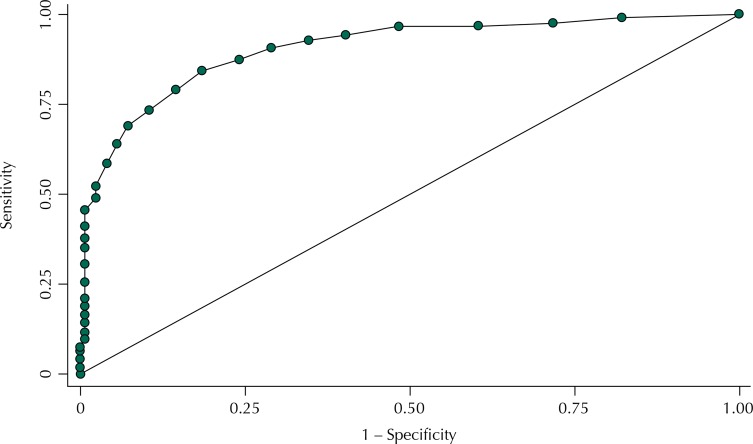
ROC curve evaluating sensitivity and specificity for different cut-off point values.